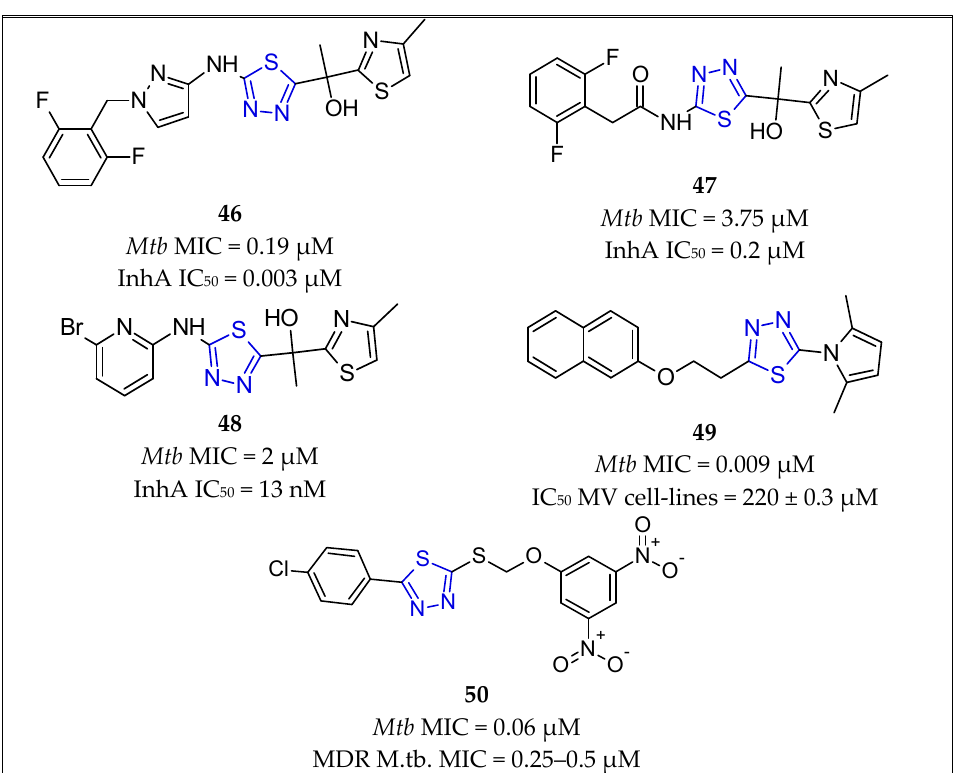
Figure 11. Chemical structures of thiadiazole-containing compounds 46 [68,69] , 47 [8] , 48 [15] , 49 [70] , and 50 [71] .